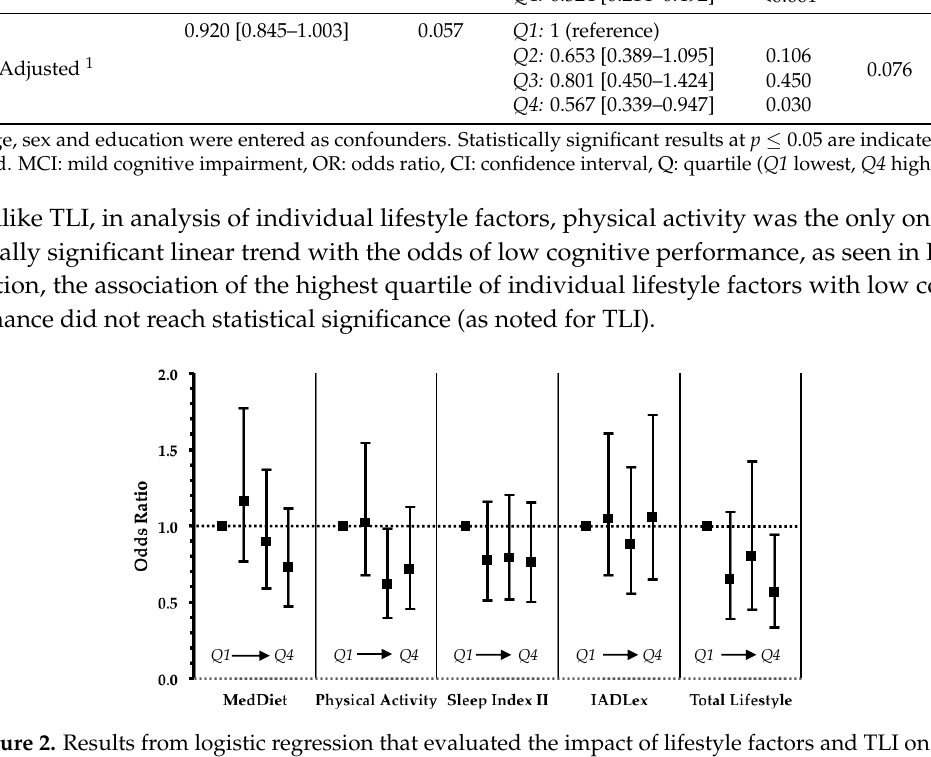
Figure 2. Results from logistic regression that evaluated the impact of lifestyle factors and TLI on the odds ratio of low cognitive performance in non-demented, non-MCI participants. Values are odds ratios with error bars representing 95% confidence intervals. In all models age, sex and education were entered as confounders. Statistically significant linear trend at p < 0.05 was observed for physical activity. MedDiet: Mediterranean diet, IADLex: instrumental activities of daily living extended scale. Q: quartile (Q1 lowest, Q4 highest).